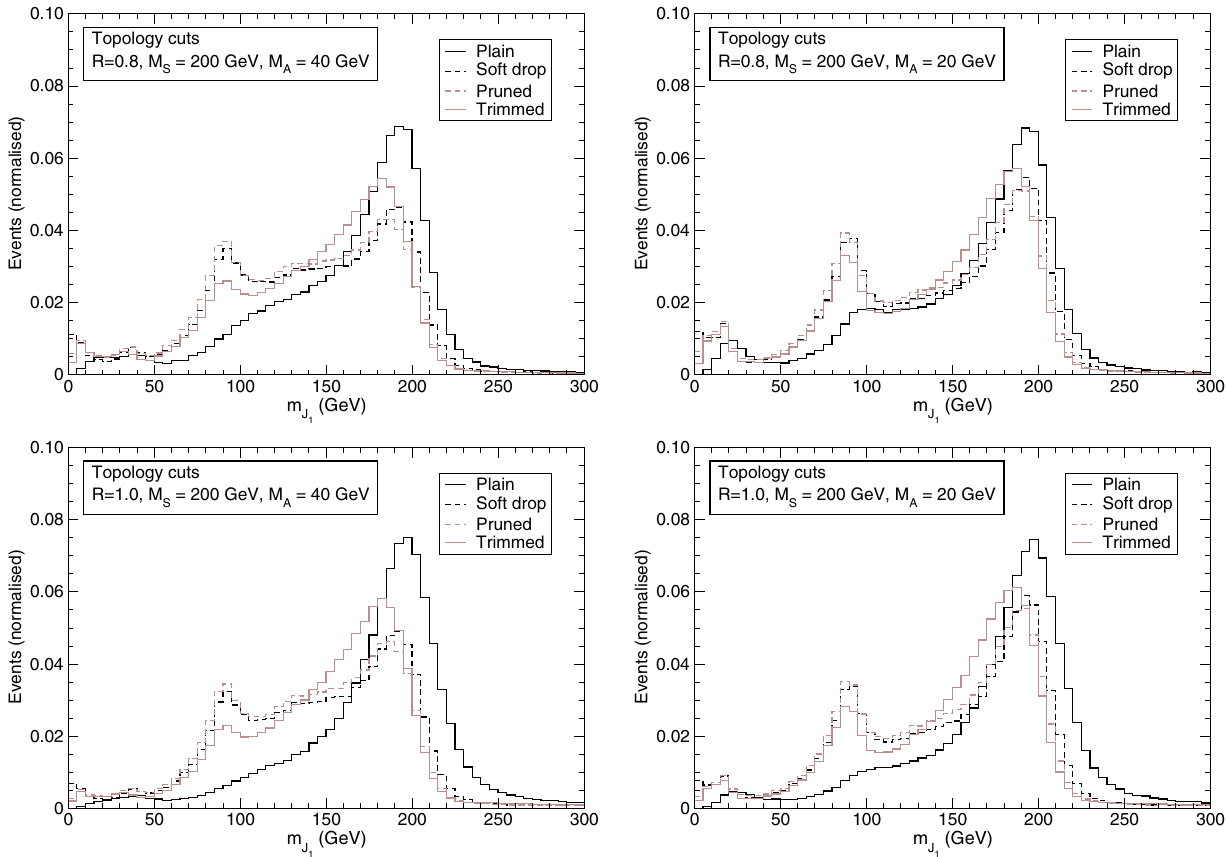
Fig. 19 Jet mass distributions for S → Z A and different grooming algorithms, for jet radii R = 0 . 8 (top) and R = 1 . 0